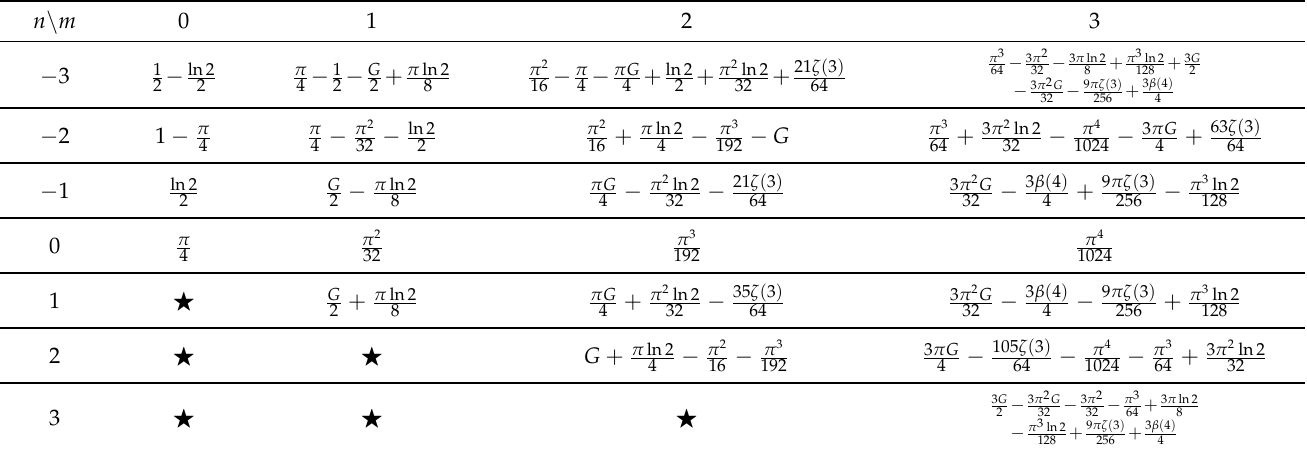
Table 4. Values for T ( m , n ) .